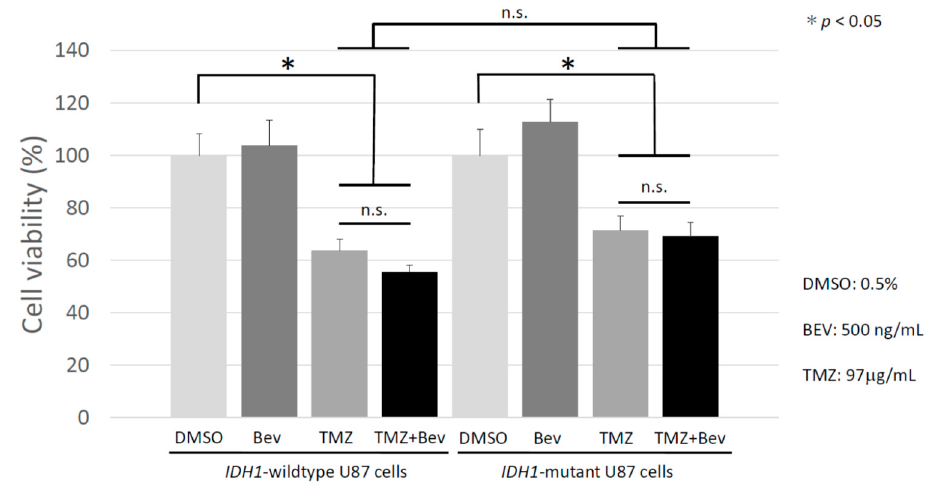
Figure 5. The viability of IDH1 -wildtype U87 cells and IDH1 -mutant U87 cells was assessed after treatment with Temozolomide (TMZ) and/or Bevacizumab (Bev). Although TMZ showed a significant antitumor effect, the addition of Bev to TMZ showed no significant add-on effect in both cell lines. * p < 0.05; n.s., not significant.